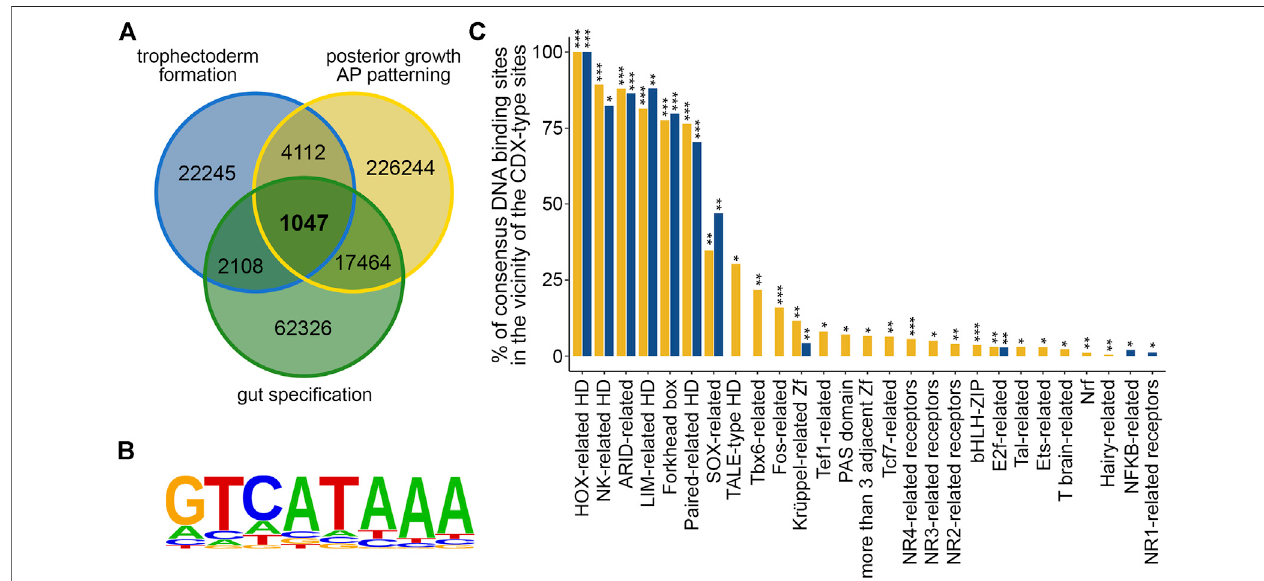
FIGURE2| ChIPseqtargetsofCDX2duringmousedevelopment.( A )ComparisonoftheCDX2-associatedchromosomalregionsduringtrophectodermformation (trophectoderm formation; blue), embryonic posterior elongation (posterior growth, AP patterning; yellow) and gut formation (gut speci fi cation; green) showing the core of1,047commonregions.( B )Consensussequenceofthe1801CDX-typemotifspresentinthe1047CDX2-boundchromosomalregions.( C )Enrichmentinconsensus binding motifs for the indicated transcription factors in the vicinity (+/50 bp) of the 1801 CDX-type sites present in the common ChIPseq regions (yellow) and in the vicinityofthe1340CDX-type sitespresent inthepromotersofthe221commonDEGs(blue). * p < 0.05,** p < 0.01,*** p < 0.00001.HD:homeodomain;Zf:zinc fi nger;h: